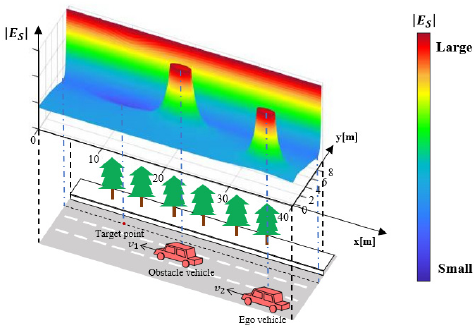
Figure 9. Overall effect of emergency safety field.